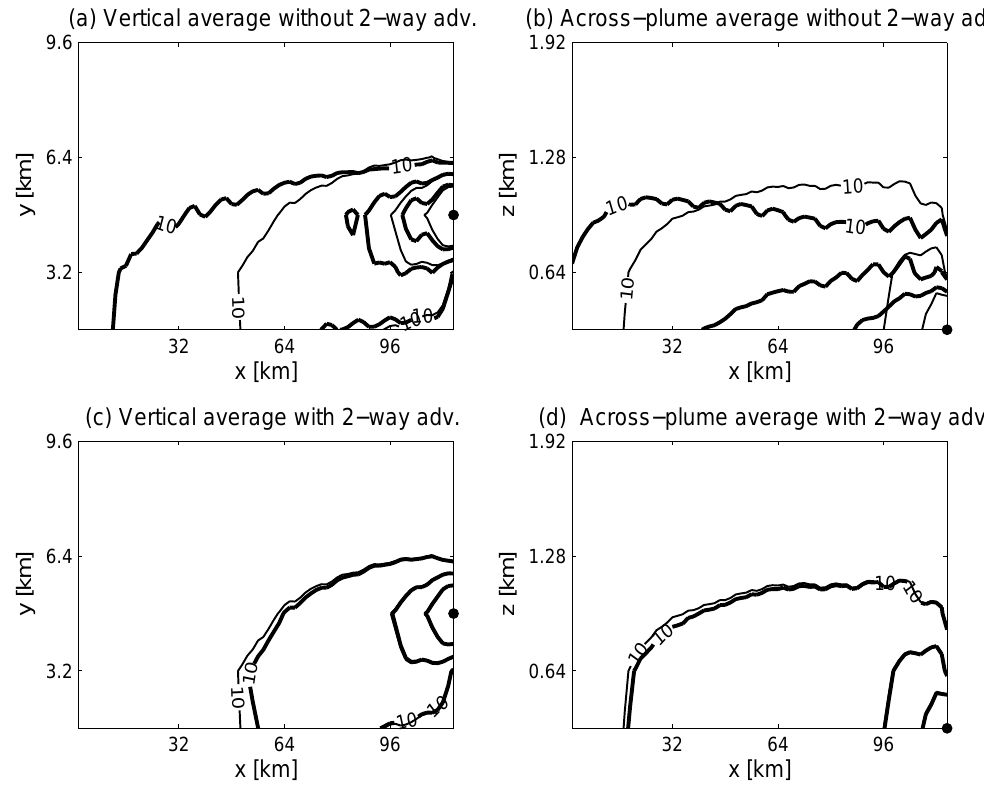
(d) Across−plume average with 2−way adv.